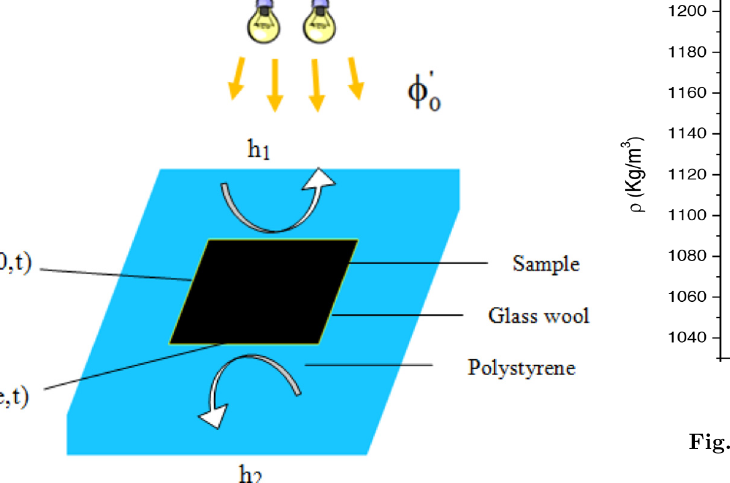
Fig. 3. Schema of the fl ash method.